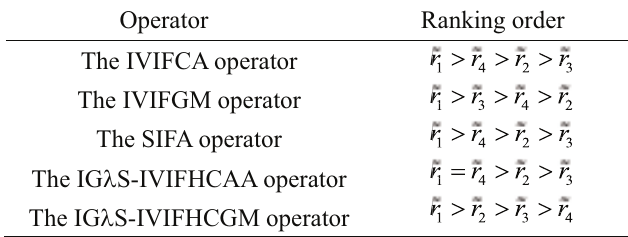
Table 1 Ranking orders w.r.t. the different aggregation operators Operator Ranking order The IVIFCA